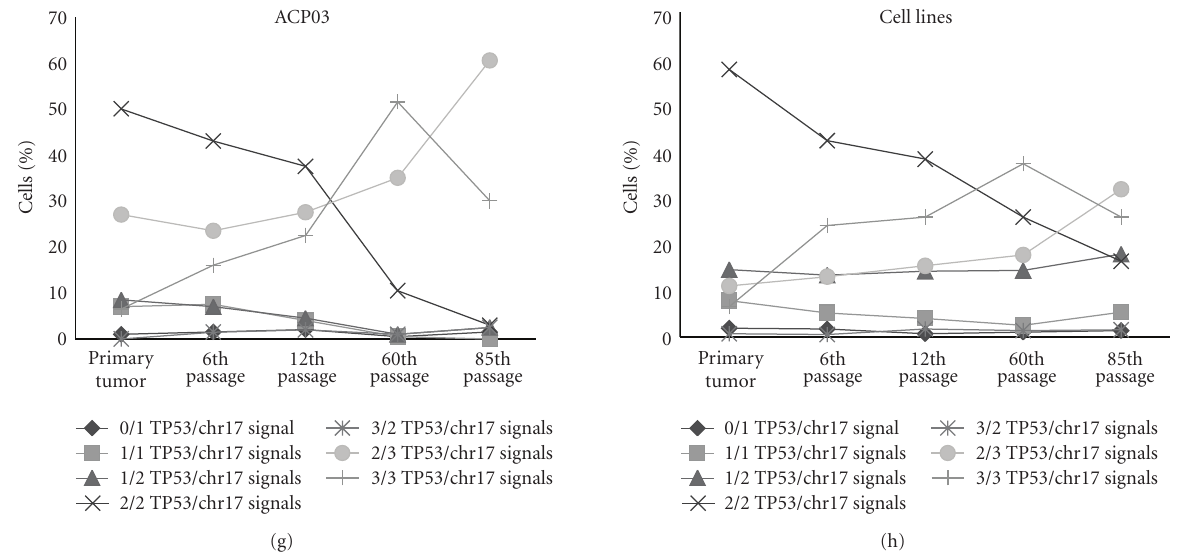
Figure 2: Distribution of cells according to (a) MYC signals in AGP01 parental tumor and cell line passages; (b) MYC signals in ACP02 parental tumor and cell line passages; (c) MYC signals in ACP03 parental tumor and cell line passages; (d) mean of MYC signals of AGP01, ACP02, and ACP03 parental tumor and cell line passages; (e) TP53 /chr17 signals in AGP01 parental tumor and cell line passages; (f) TP53 /chr17 signals in ACP02 parental tumor and cell line passages; (g) TP53 /chr17 signals in ACP03 parental tumor and cell line passages; (h) mean of TP53 /chr17 signals of AGP01, ACP02, and ACP03 parental tumor and cell line